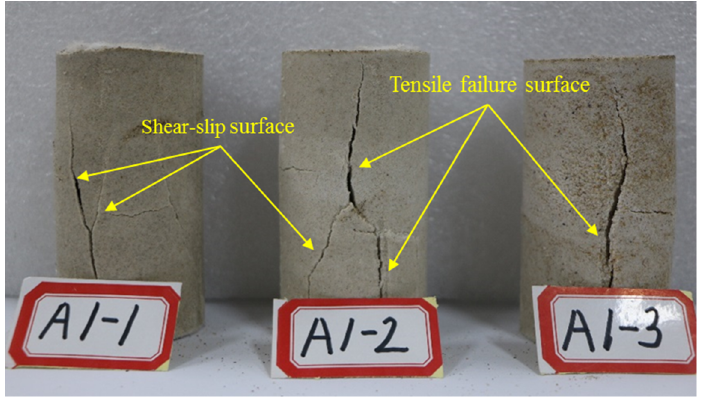
Figure 8. Failure mode of unconfined compressive strength test of bio-treated sand column.